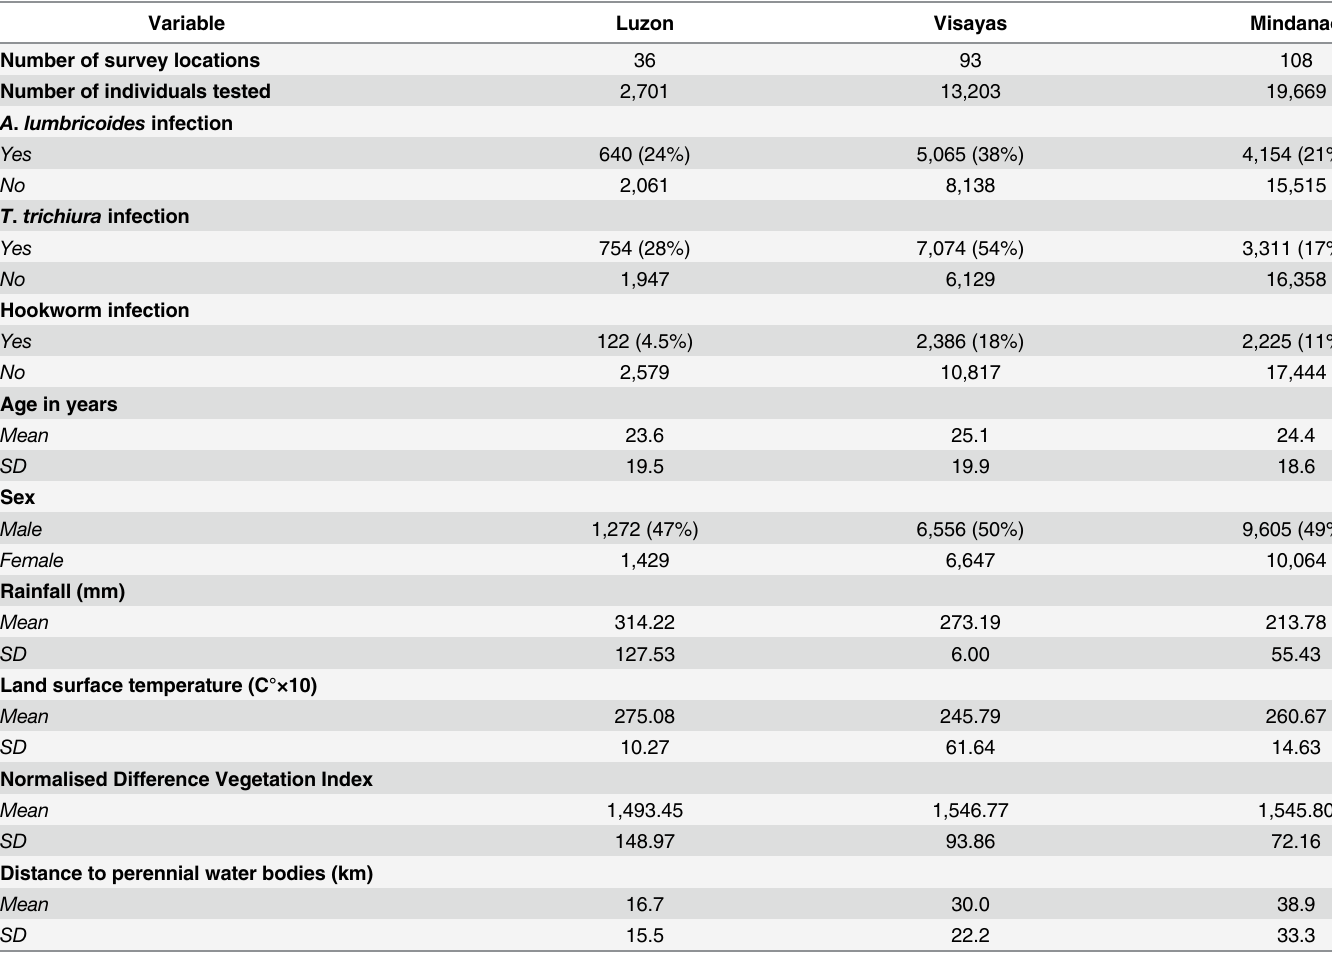
Table 1. Characteristics of 35,573 individuals and properties of the physical environment of survey locations included in the